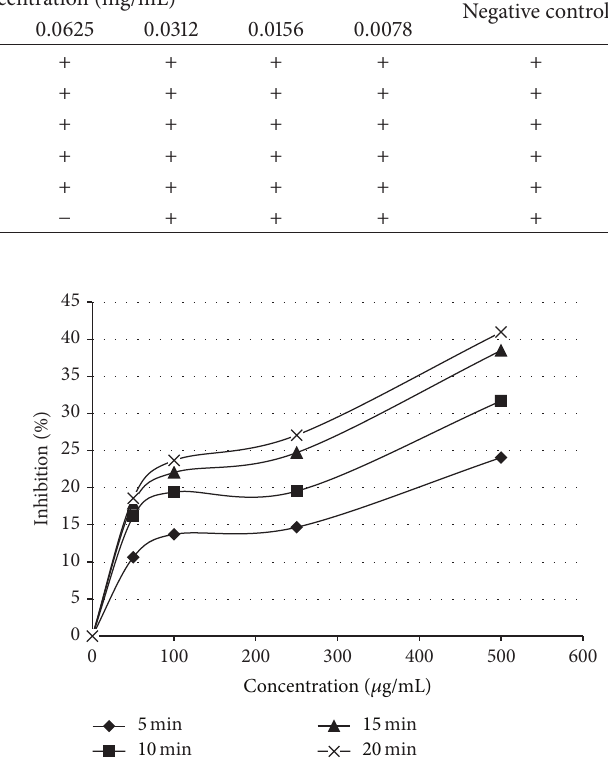
Figure 4: Scavenging of ABTS radical from cones essential oil of Cupressus sempervirens